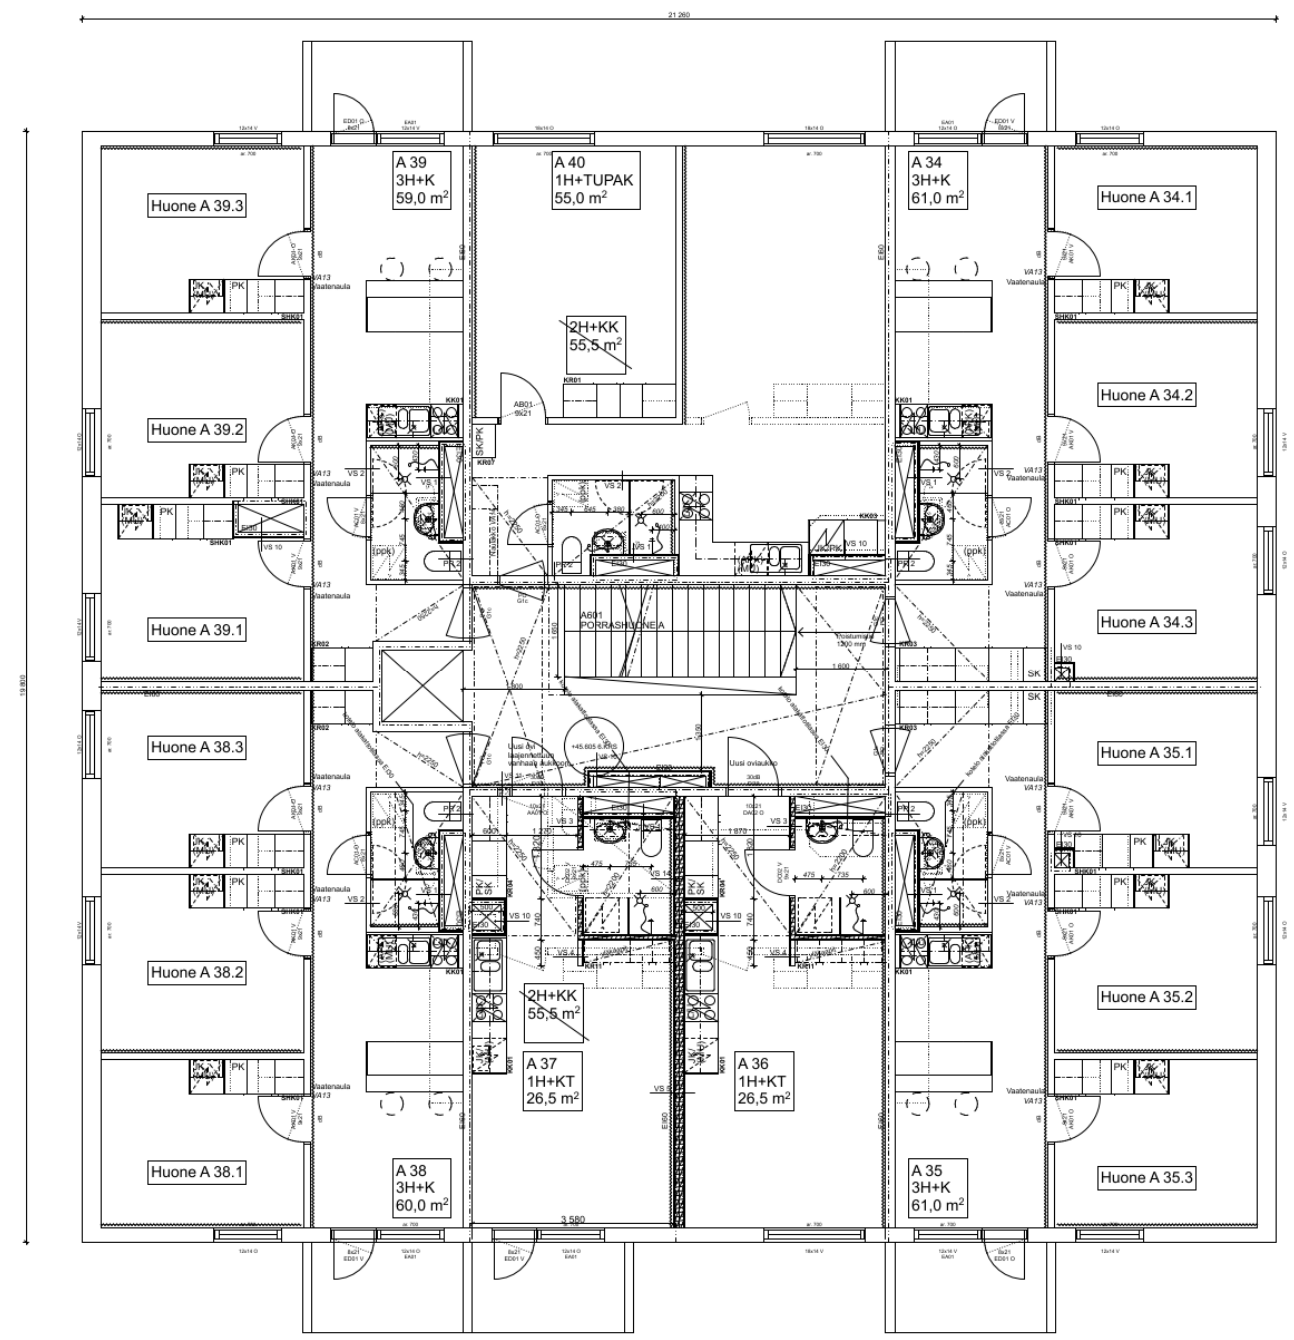
Figure 4. Floor plan of a residential floor of the case site. Table 1. Takt work in the apartments in the case site.